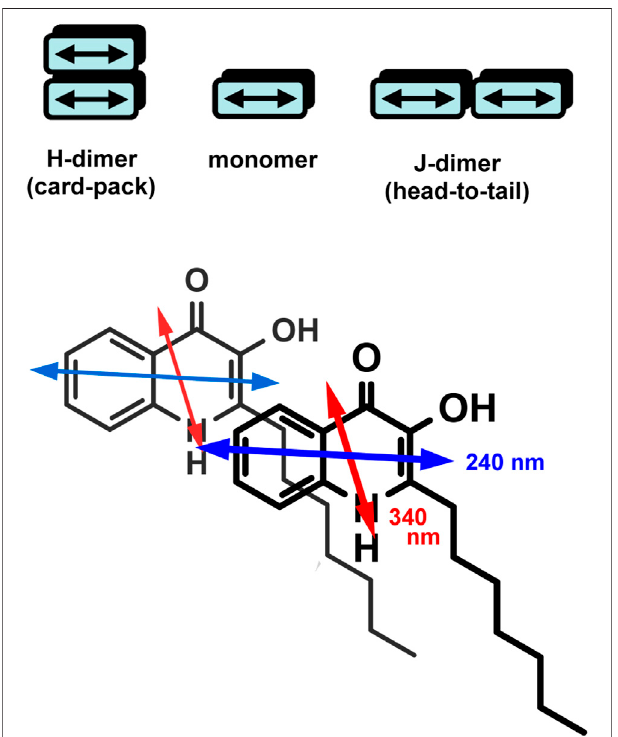
SCHEME 2 | Top: illustration of aggregated dimers in H- and J-type arrangement. Per molecule, one electronic transition dipole moment is shown (double-headed arrow). Bottom: a hypothetical J-dimer formed by two PQS molecules. Note the head-to-tail relative orientation of the respective etdms.